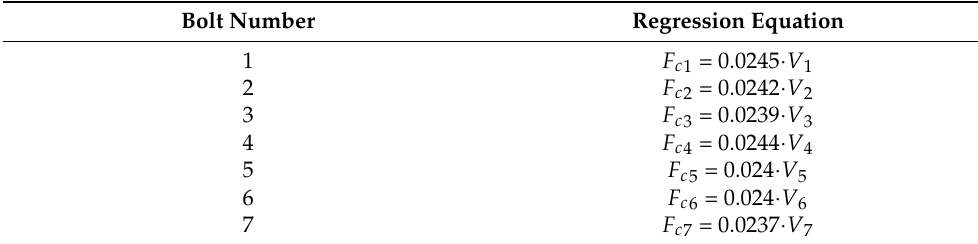
Figure 3. Equipment for calibration of the bolts: ( a ) diagram (1—special bolt, 2—handle, 3—nut, 4—washer, 5—plate, 6—spherical sleeve, 7—M10 × 1.25 bolt), ( b ) general view. Table 1. Results of the bolt calibration. Table 1. Results of the bolt calibration.